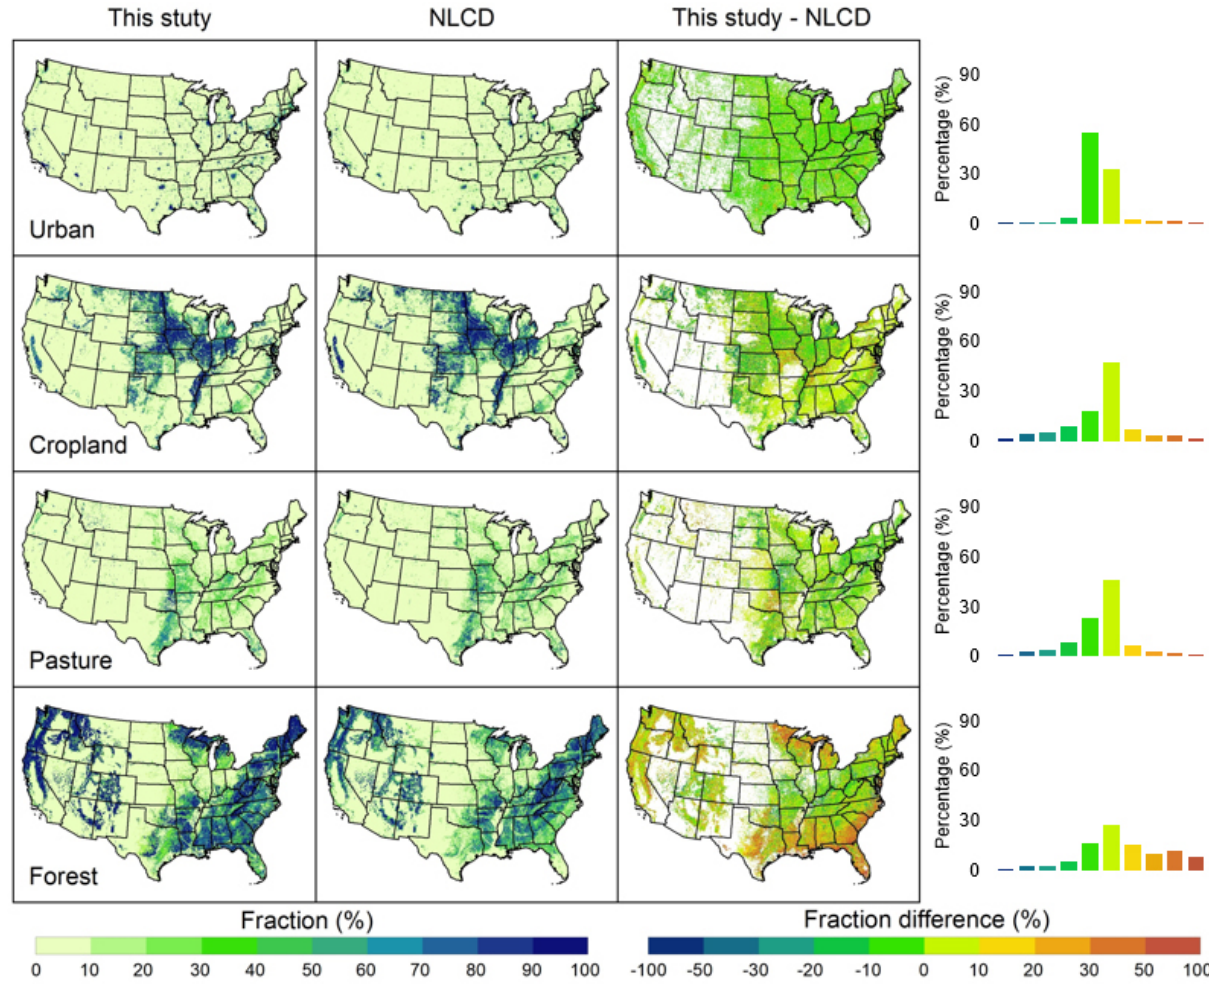
Figure 11. Spatial comparison between our reconstruction and satellite-based urban, cropland, pasture, and forest. First column: recon- structed data in this study (average between fraction of 2001, 2003, 2006, 2008, 2011, 2013, 2016, and 2019), second column: satellite-based data (average fraction of 2001, 2003, 2006, 2008, 2011, 2013, 2016, and 2019), third column: difference between first column and second column, and fourth column: distributions of fraction difference between our reconstructed database and satellite-based